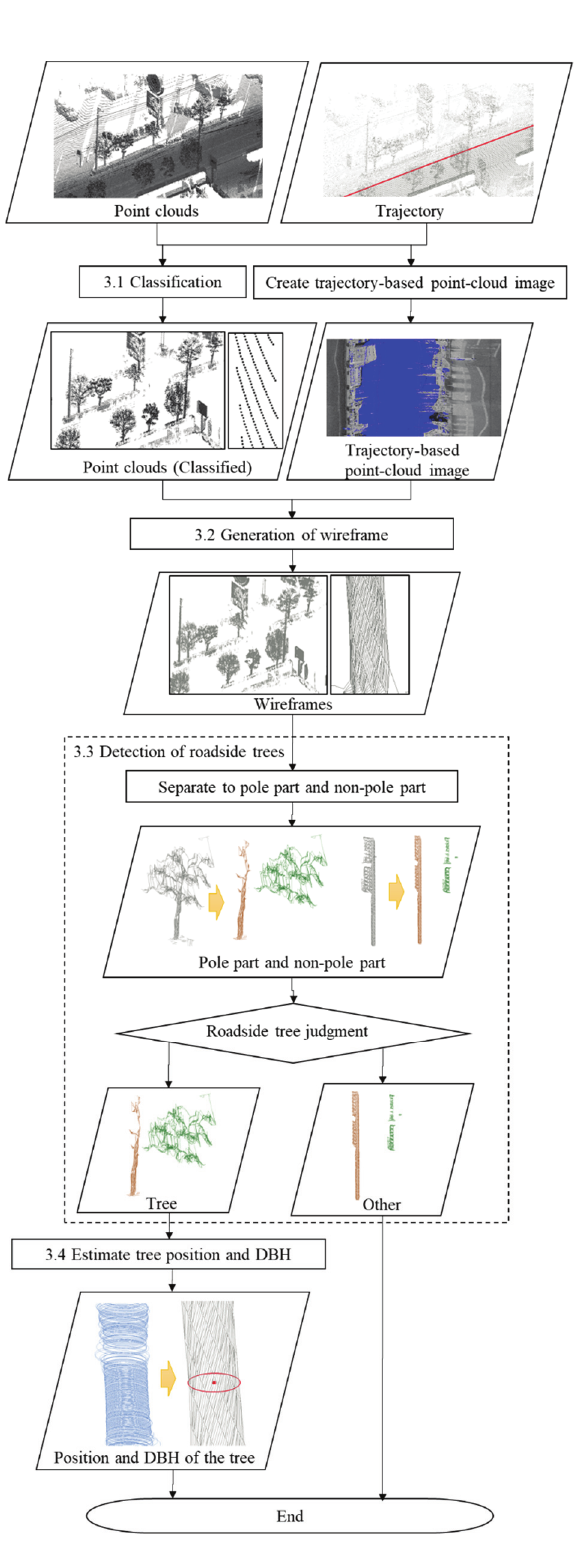
Figure 1 . Process flow of roadside tree extraction curvature are defined as shown in Figure 2. The scanline curvature is the ratio of the distance from the straight line connecting the start and end points of a scanline. All points in the same scanline share the same scanline length and curvature.